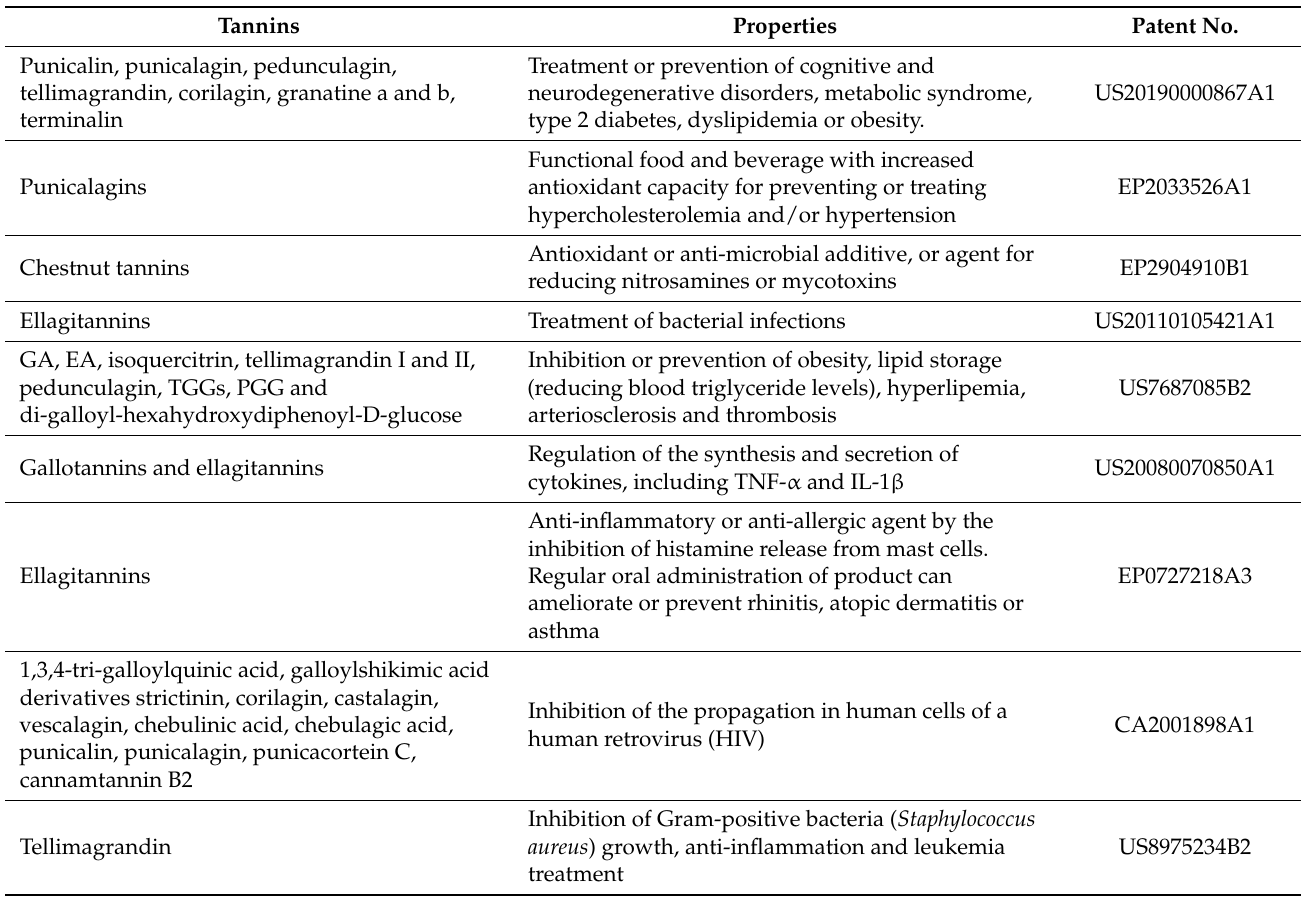
Table 1. Examples of patented tannin